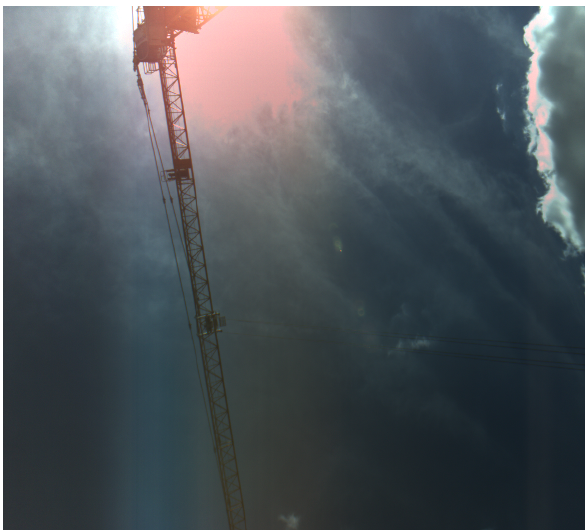
Figure 1: Example of rosy artifacts in the case of a flat-field cor- rection without prior rejection of overexposed pixels.